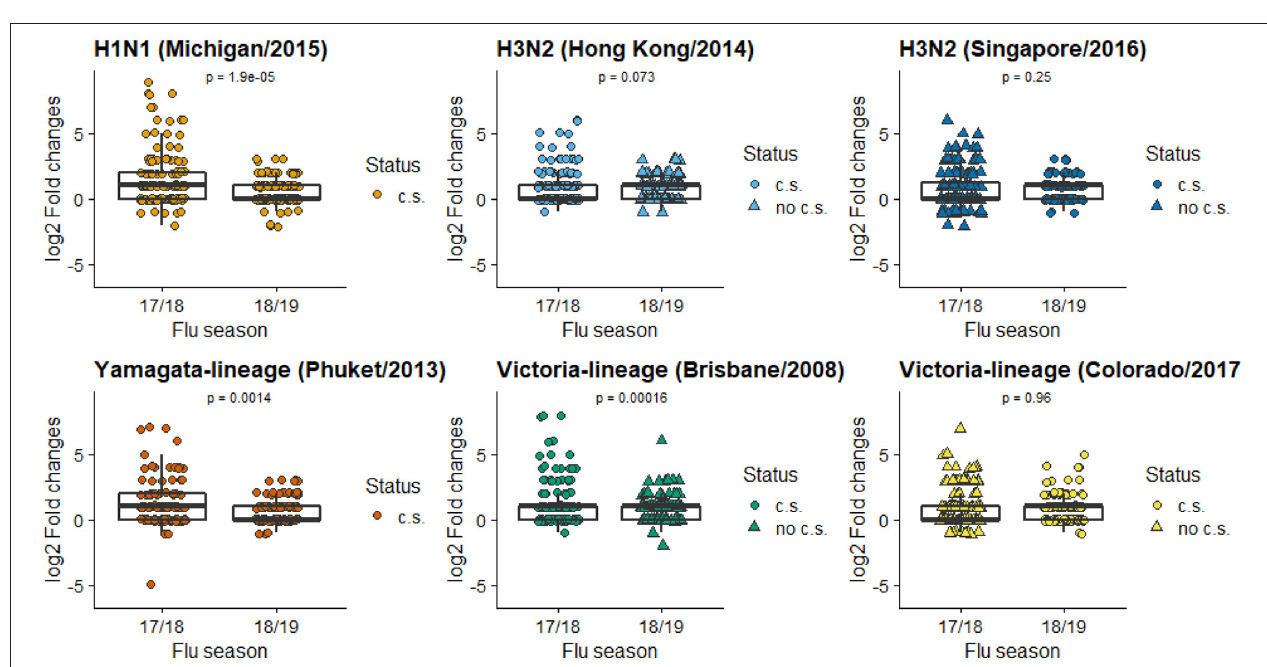
FIGURE 3 | Mean folds changes in HAI titers for each vaccine component strain. (c.s. in current season’s vaccine formulation; no c.s. not in current season’s vaccine formulation). The Y axis is the log2 transformed fold of changes in HAI titers pre- and post-vaccination, calculated by log 2( HAI post